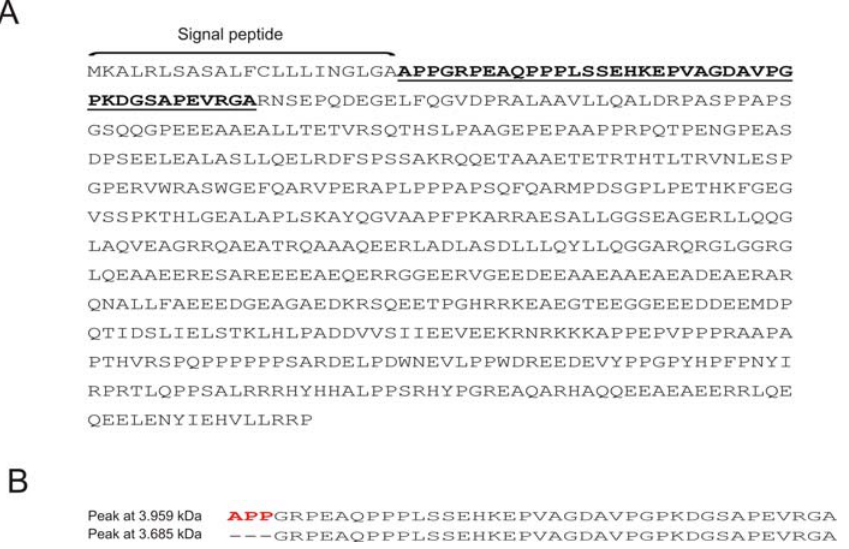
Figure 3. Mapping and Identification of the Biomarker Peptide Derived from the Native VGF Protein The 3,959-Da ‘‘ schizophrenia ’’ peptide was mapped to amino acids 23–62 of the native VGF protein (in bold; underlined), immediately next to a predicted secretory signal peptide (using InterProScan: www.ebi.ac.uk/ cgi-bin/iprscan). Another native VGF-derived peptide did not show differential expression between healthy volunteers and patients with schizophrenia (as shown in Figure 2A). This peptide has an identical sequence except that it is three amino acids shorter at the N-terminus compared to the ‘‘ disease-specific ’’ VGF peptide.